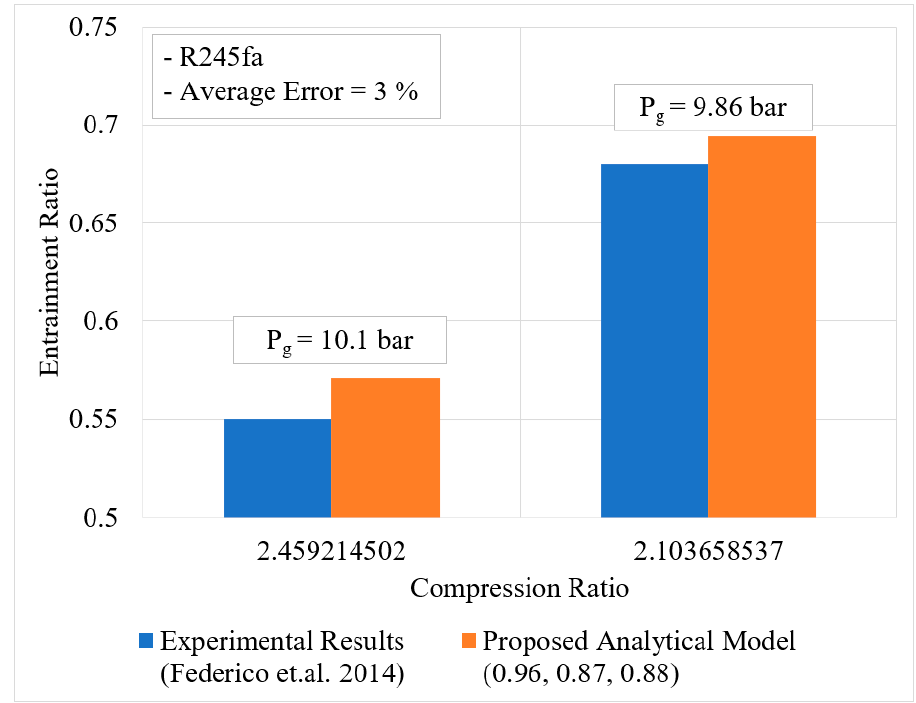
Figure 12. Validation of model with published experiment data.